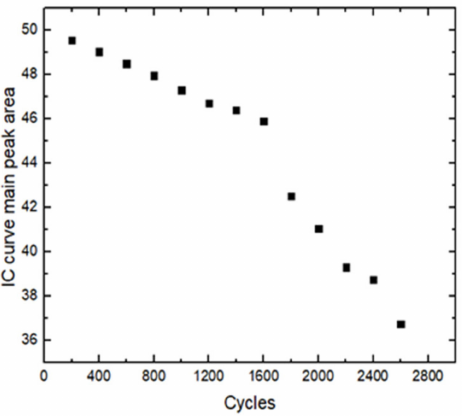
Figure 6. The area of the main peak of the IC curve the number of cycles.